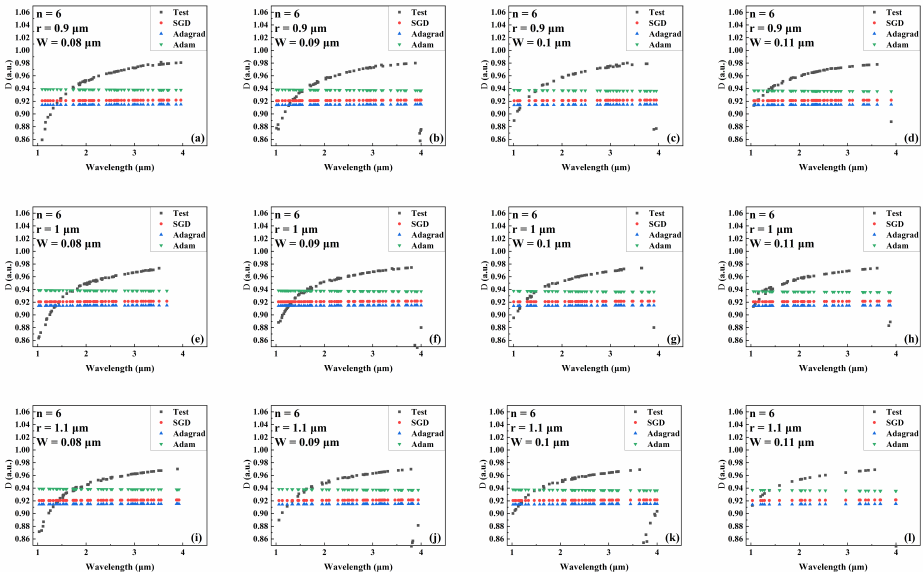
Figure 14. Comparision the predicted and actual values of D in the test data set of the network model trained by different optimizers for different combinations of core radius and cantilever width (number of cantilevers: 6). ( a ) r = 0.9 µ m, W = 0.08 µ m. ( b ) r = 0.9 µ m, W = 0.09 µ m. ( c ) r = 0.9 µ m,